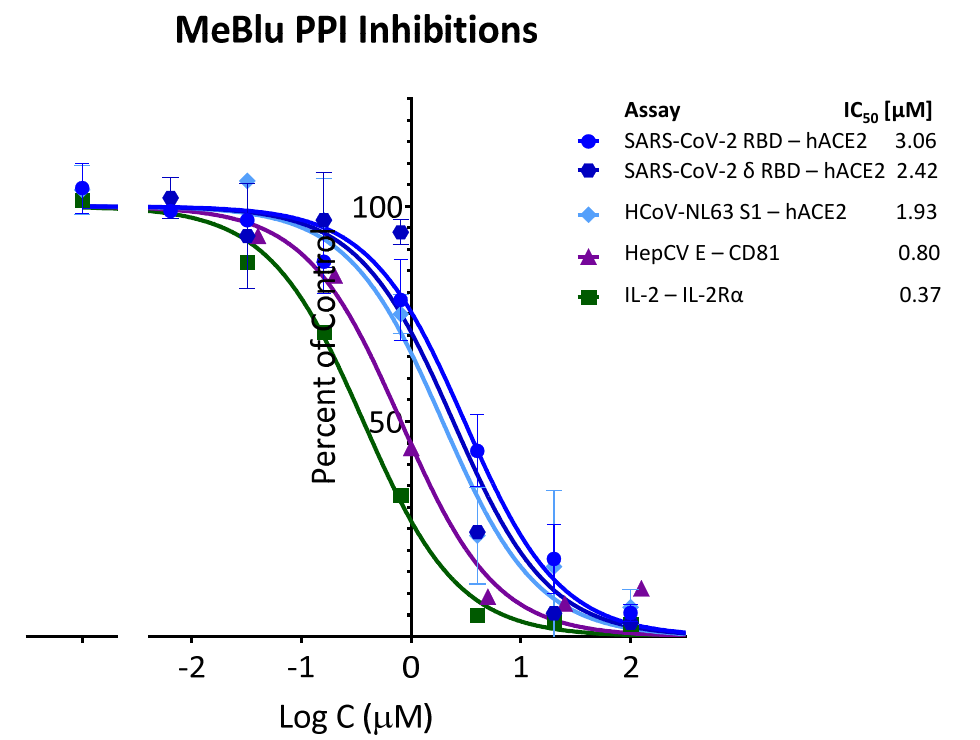
Figure 3. Promiscuous PPI inhibitory activity of MeBlu. Methylene blue inhibited several protein– protein interactions as assayed here in concentration-dependent manner following typical law of mass action response (i.e., unity Hill slope, n H = 1). In addition to coronavirus spike protein interactions with human ACE2, including SARS-CoV-2, its delta variant of concern, and the cold-causing HCoV-NL63, it also inhibited the PPIs of hepatitis C virus envelope glycoprotein E with CD81 as well as others such as IL-2–IL-2R α with similar potency. Data (mean ± SD) for each assay as indicated were normalized and fitted with standard inhibition curves; obtained IC 50 values are shown at right.